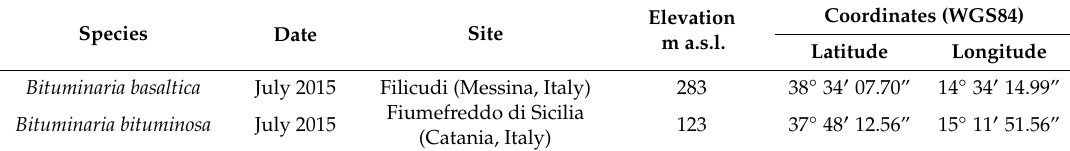
Table 1. Sampling locations for Bituminaria basaltica and B. bituminosa .